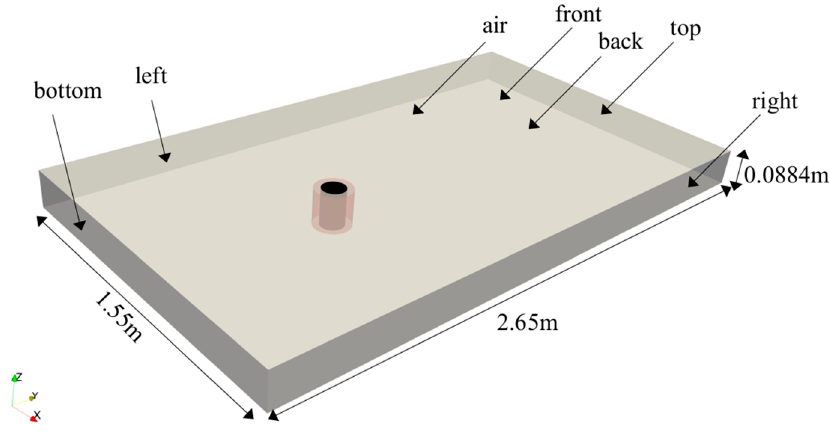
Figure 2. Three-dimensional view and dimensions of the validation problem.